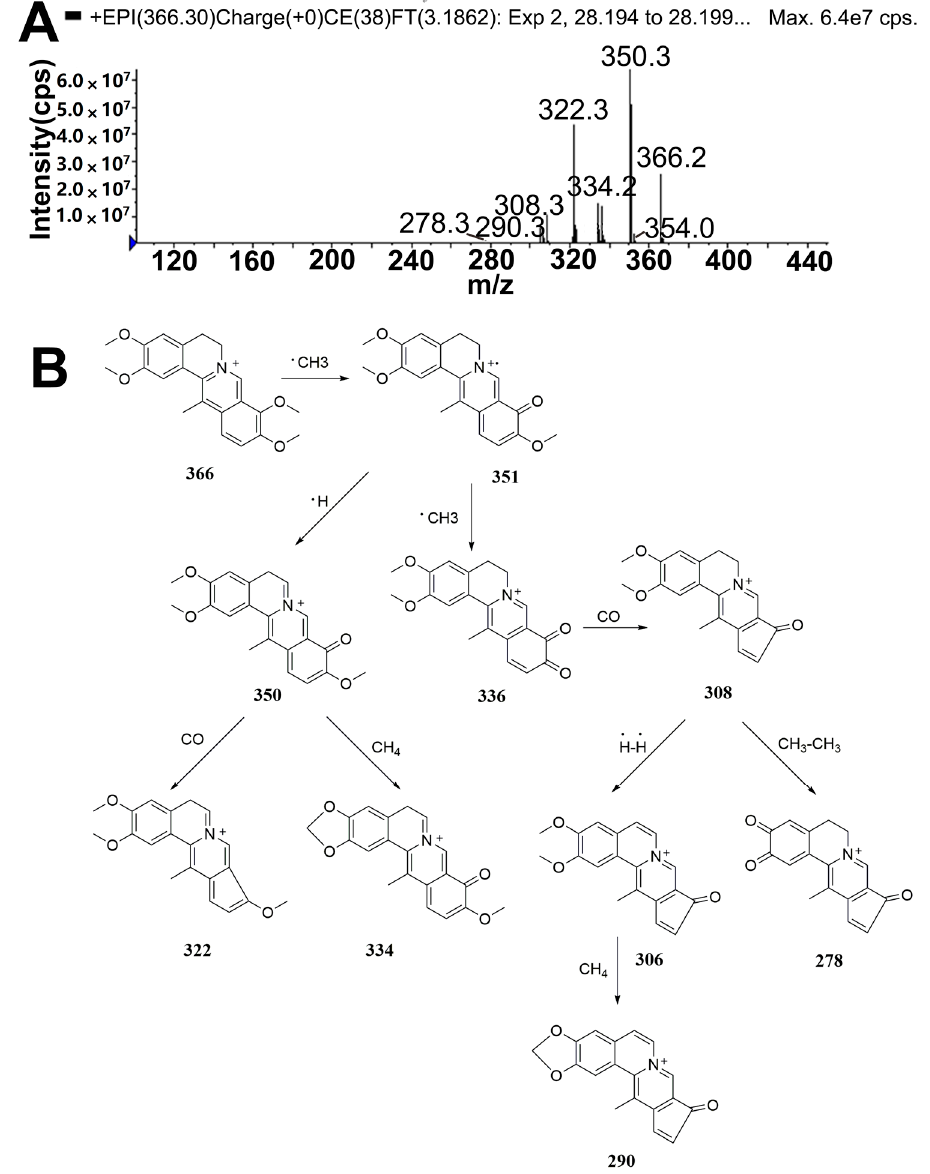
Figure 1. Mass spectrometry (MS 2 ) spectrum ( A ) of dehydrocorydaline (DHC) and its proposed fragmentation pathways ( B ).